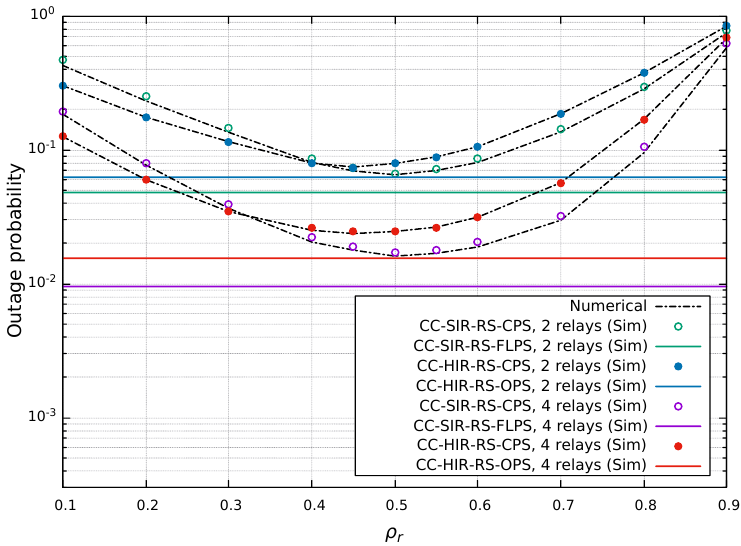
Figure 8. Numerical and simulated outage probability results of the CC-HIR-RS-CPS and CC − SIR-RS- CPS schemes when applying different ρ r in the interval [ 0.1,0.9 ] and comparison with the CC-HIR-RS-OPS and CC-SIR-FLPS schemes for different relay numbers, E b / N 0 = 10 dB, and γ th =